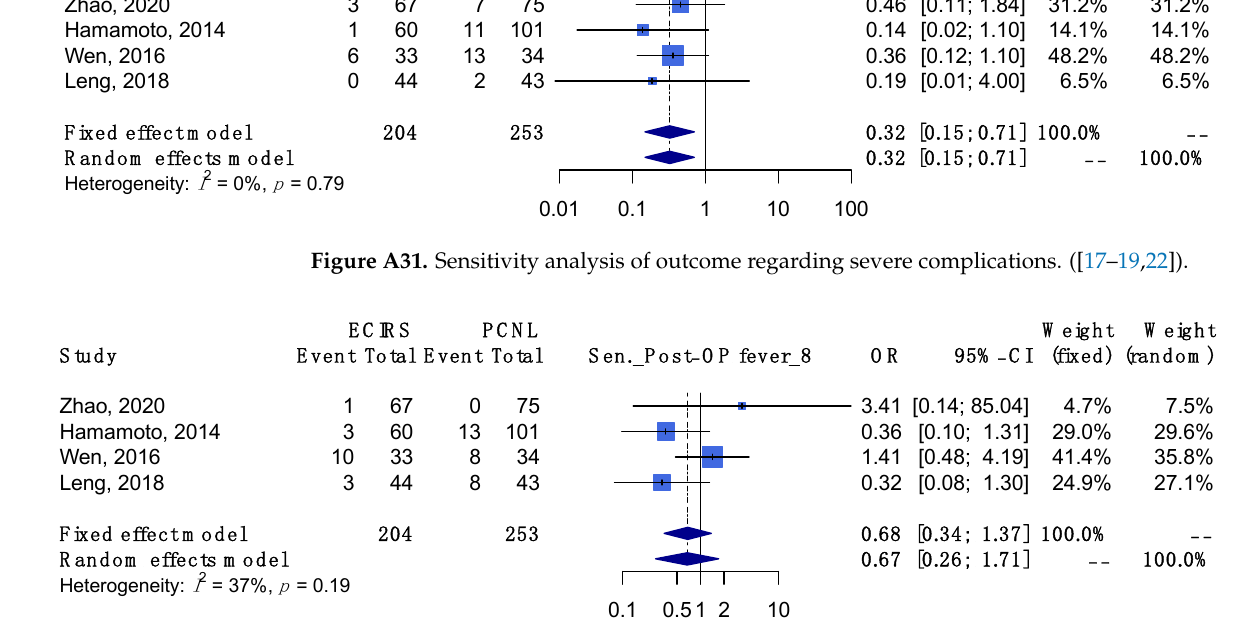
Figure A32. Sensitivity analysis of outcome regarding post-operative fever. ([17–19,22])